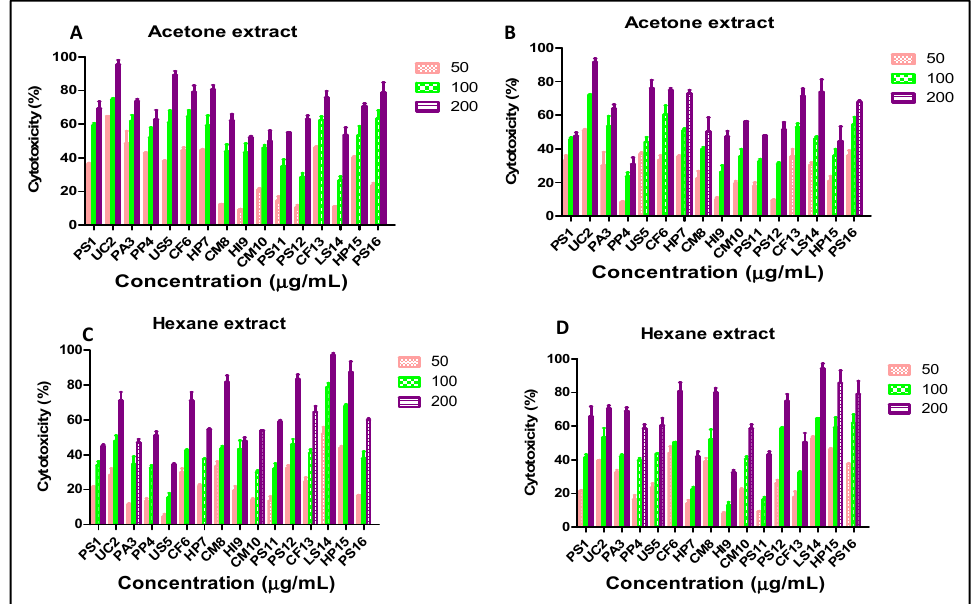
Figure 1. Cytotoxicity of lichen extracts observed via MTT assays after 24 h of treatment; ( A ) acetone extract against HeLa cells; ( B ) acetone extract against MCF-7 cells; ( C ) hexane extract against HeLa cells; ( D ) hexane extract against MCF-7 cells. Table 1. Cytotoxicity (IC 50 ) of lichen acetone and hexane extracts against HeLa and MCF-7 cells after 24 h of treatment. PS: Parmelia sulcata, UC: Usnea cornuta, PA: Parmelia andinum, PP: Parmotrema perlatum, US: Usnea sp., CF: Collema flaccidum, HP: Hypogymnia physodes, CM: Cladonia macilenta, HI: Heterodermia indica, CM: Cladonia macilenta, PS12 :Parmelia sp. 12, LS: Leptogium sp., PS16: Physcia sp. S. No Lichen Extract Acetone Extract IC 50 ( µ g/mL) Hexane Extract IC 50 ( µ g/mL) HeLa